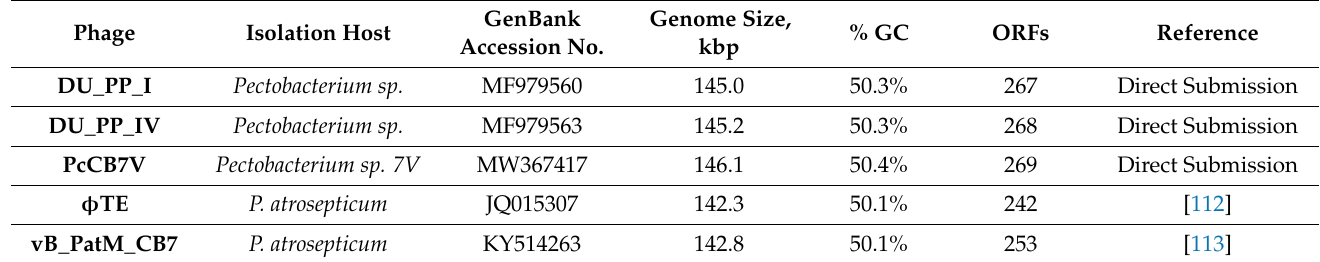
Table 2. Genomic properties of Vequintavirinae bacteriophages infecting SRP.